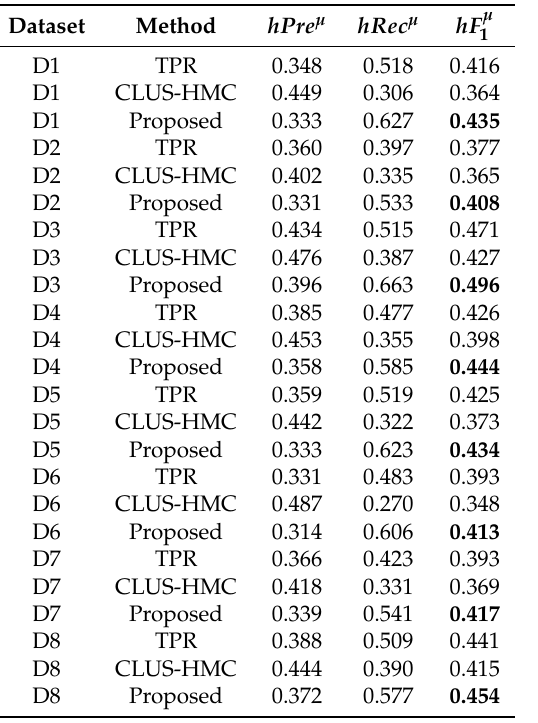
Table 3. The micro-averaged version of experimental results on eight data sets.